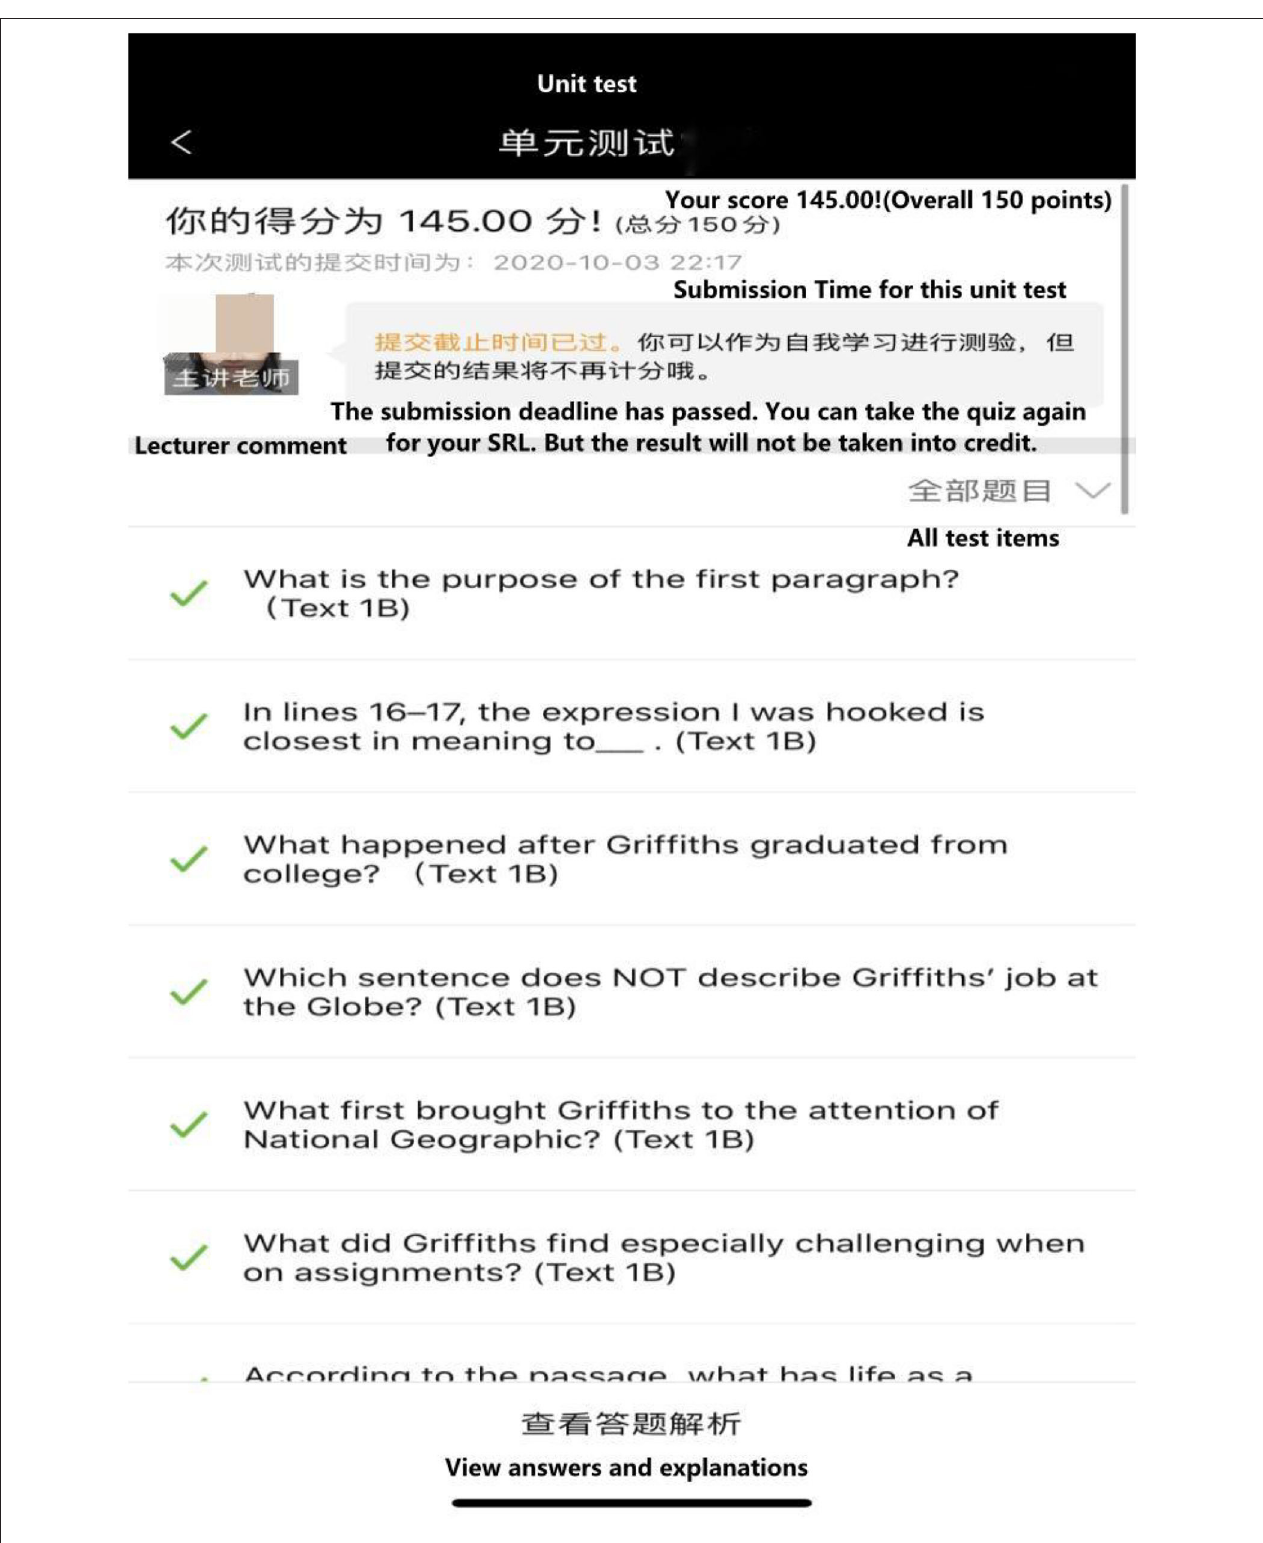
FIGURE 3 | Icourse—Online quiz